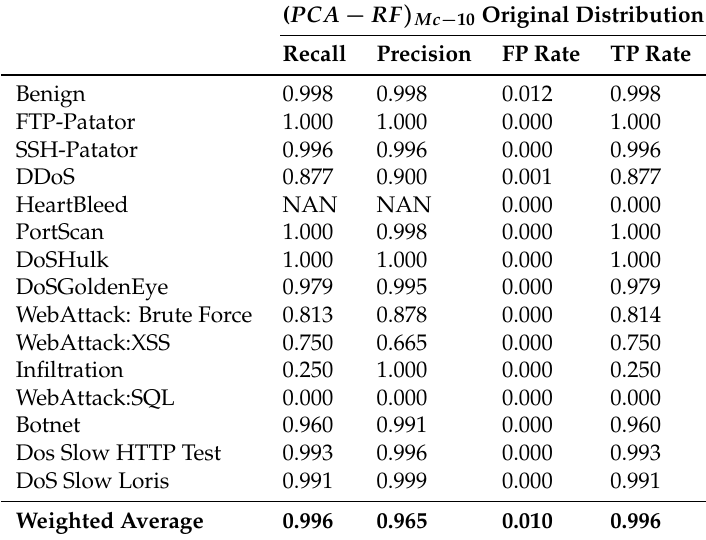
Table 12. Performance evaluation before applying UDBB.